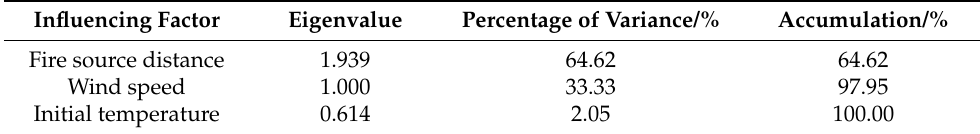
Table 2. Eigenvalues and Variance Percentages of Correlation Matrix in Multivariate